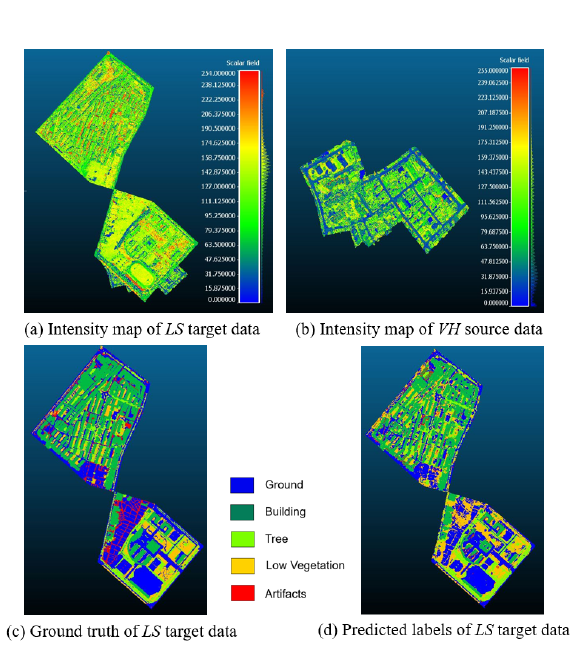
Figure 3. The inference result visualisation (experiment III).